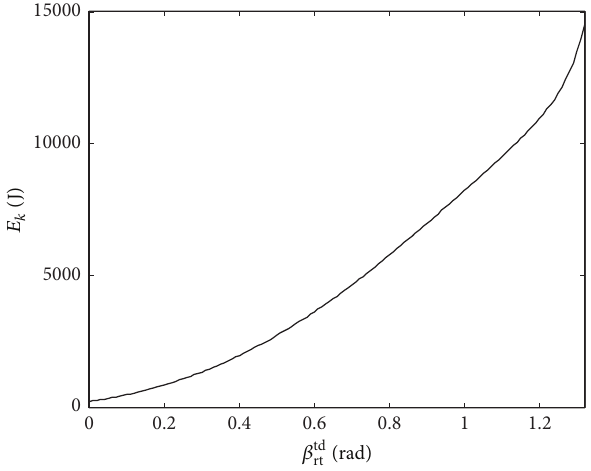
Figure 4: Maximum elastic potential energy stored in the rear legs.